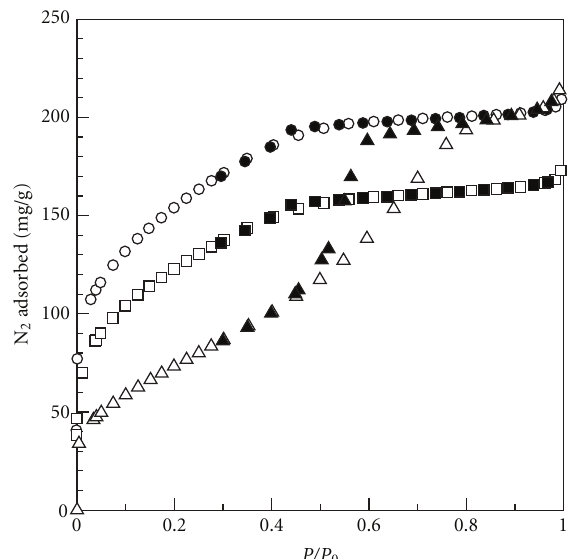
Figure 6: N 2 adsorption isotherms of the titanium oxide nanopar- ticles obtained by heating the mixture of ethylene glycol solution of TIP and NH 3 (aq) at 77K. (cid:3) , (cid:2) : adsorption and desorption isotherms of [NH 3 ] = 1 mol/L. (cid:2) , (cid:3) : adsorption and desorption isotherms of [NH 3 ] = 0.1mol/L. (cid:4) (cid:5) : adsorption and desorption isotherms of particles obtained by heating the mixture of TIP and H 2 O at 368 K for